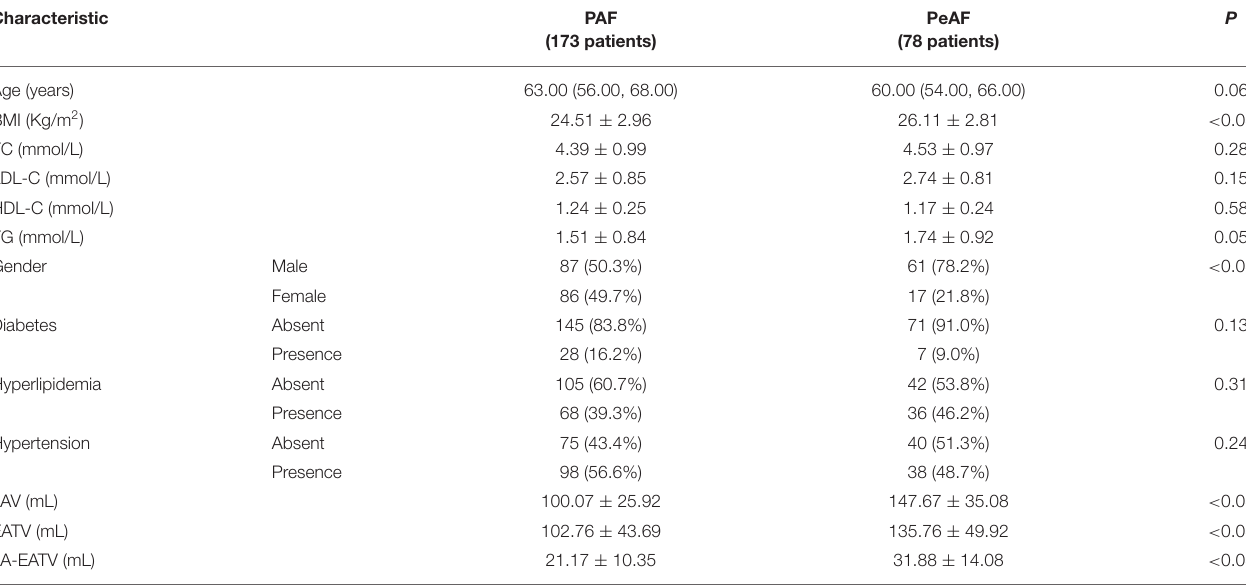
TABLE 2 | Univariate analysis of clinical characteristics and morphological parameters in the PAF and PeAF training cohorts. Characteristic